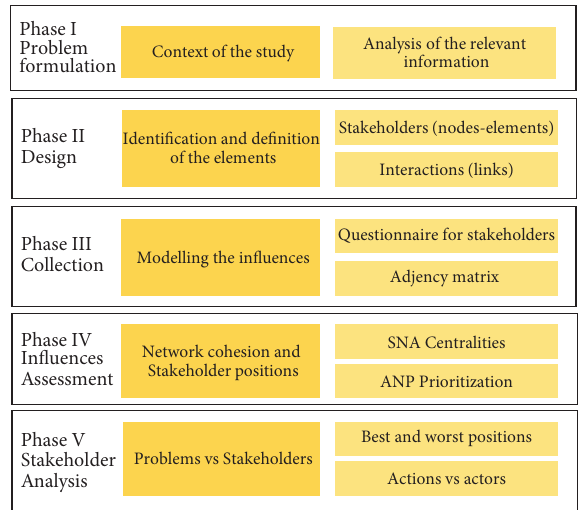
Figure 1: The SNA-ANP proposed